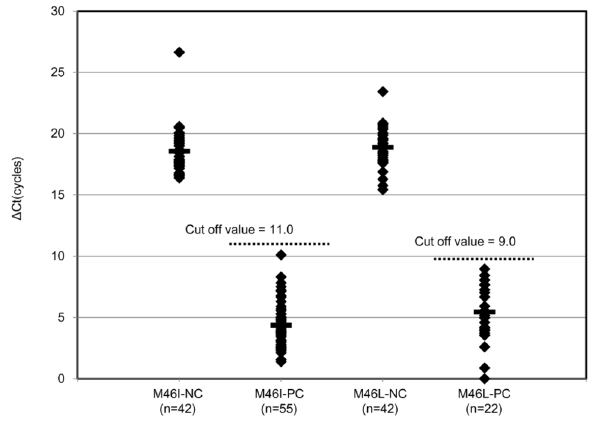
Figure 3. Assay reactivity with wild-type and M46I/L mutation clinical samples. Dotted ΔCT values from clinical samples with sequence-detectable mutations and with wild- type sequences are shown. The range of reactivity for each assay is shown for wild-type and mutant samples. The mean of ΔCT (bar) for each group is indicated. Assay cutoffs (dotted horizontal line) were established to exclude all wild-type viruses from detection. PC; Positive clones with M46I/L, NC; Negative clone with no M46I/L(wild type). doi: